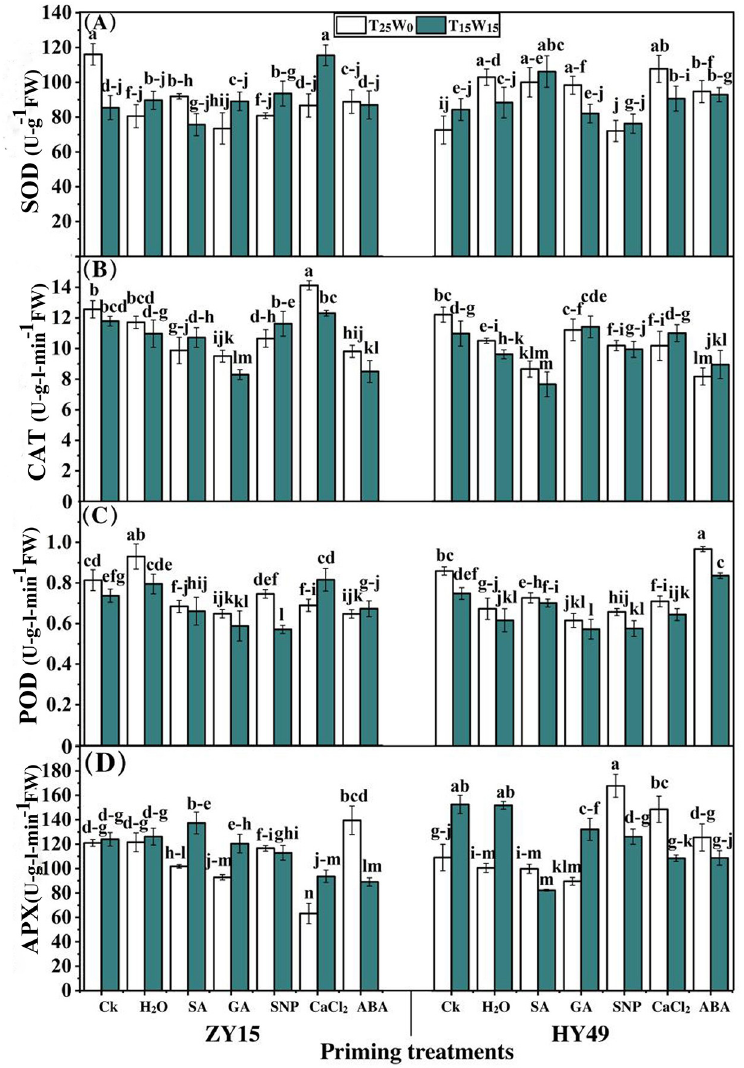
Fig 4. Effects of different priming solutions on antioxidant enzyme activities of rape seedlings under low temperature and drought conditions. Effects of low temperature and drought stressed (25˚C and 0 MPa, 15˚C and -0.15 MPa) on antioxidant enzyme activity with ( A ) superoxide dismutase (SOD), ( B ) catalase (CAT), ( C ) peroxidase (POD), and ( D ) ascorbate peroxidase (APX) in Brassica napus seedlings (varieties ZY15 and HY49). Seven different treatments were evaluated: ( a ) control (Ck), ( b ) water (H 2 O), ( c ) salicylic acid (SA), ( d ) gibberellic acid (GA), ( e ) sodium nitroprusside (SNP), ( f ) calcium chloride (CaCl 2 ), and ( g ) abscisic acid (ABA). Each point represents the mean of three replicates. The values presented are the mean ± standard deviation (SD). Significant differences among treatments were determined by a three-way analysis of variance (ANOVA) (p < 0.05 according to Duncan’s multiple range